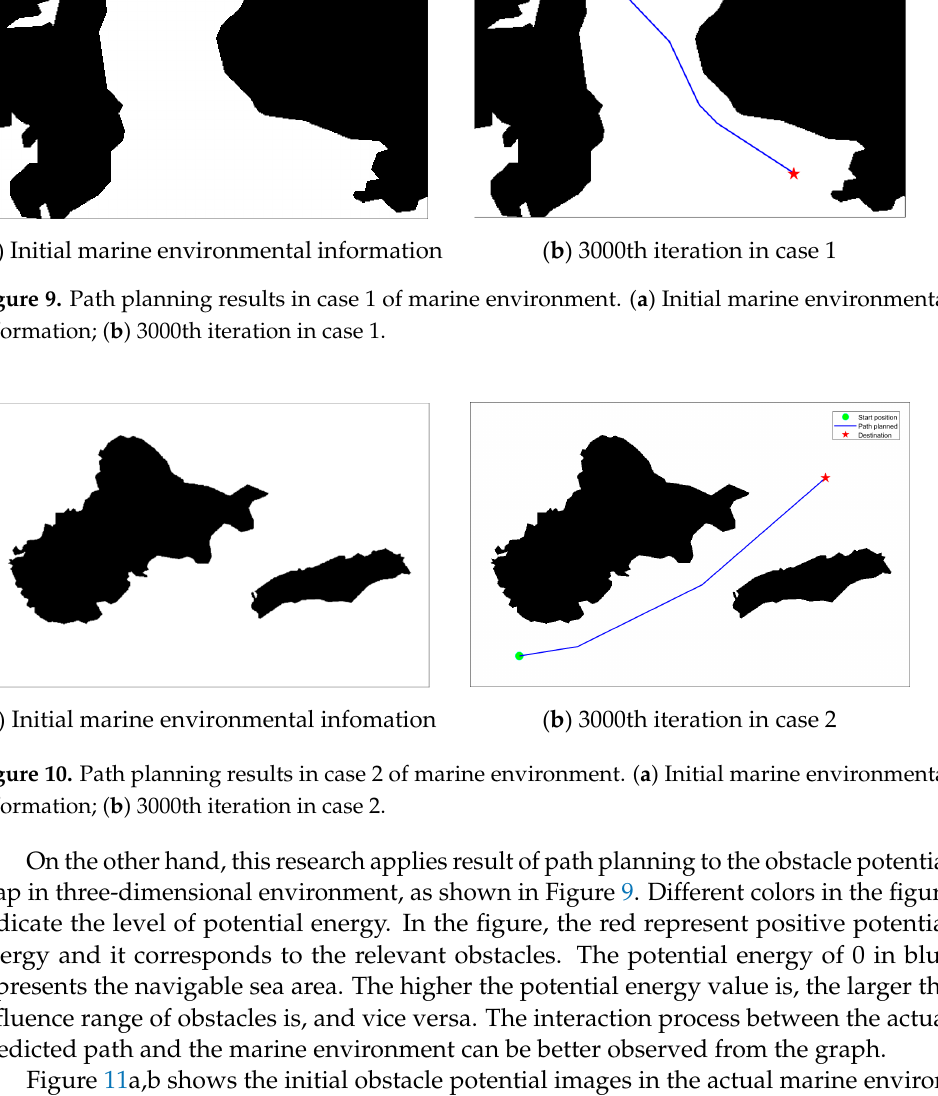
( d ) Figure 11. Combination of obstacle potential and DQN-based ship path planning. ( a ) Initial marine environment of obstacle potential; ( b ) Initial position of starting point and target point; ( c ) Model prediction path process; ( d ) Model prediction end of path